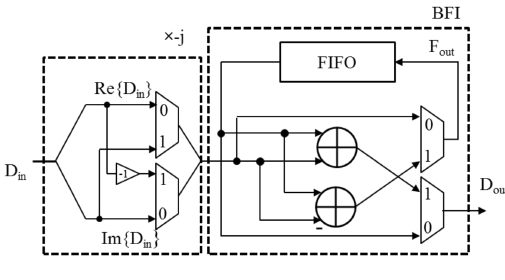
Figure 4. Butterfly unit BFII.